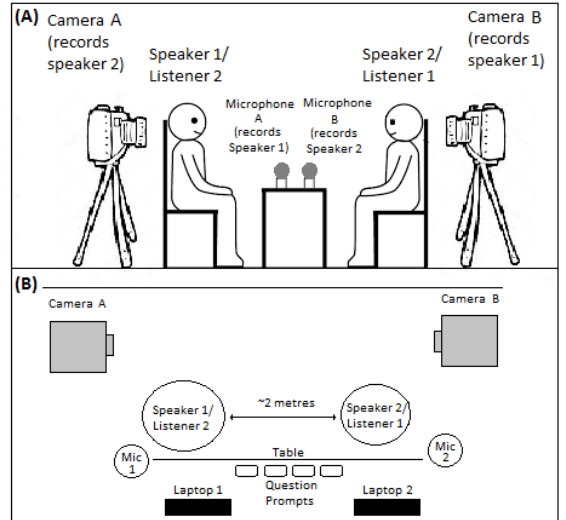
Figure 9 | (A) A side on view of the experimental setup from a third party observer and (B) the setup from the participants’